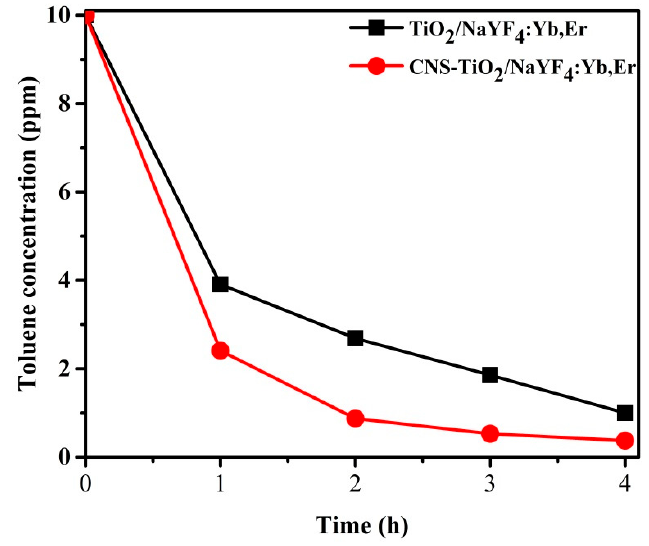
Figure 10. Photodegradation for toluene with CNS-TiO 2 /NaYF 4 :Yb,Er and TiO 2 /NaYF 4 :Yb,Er